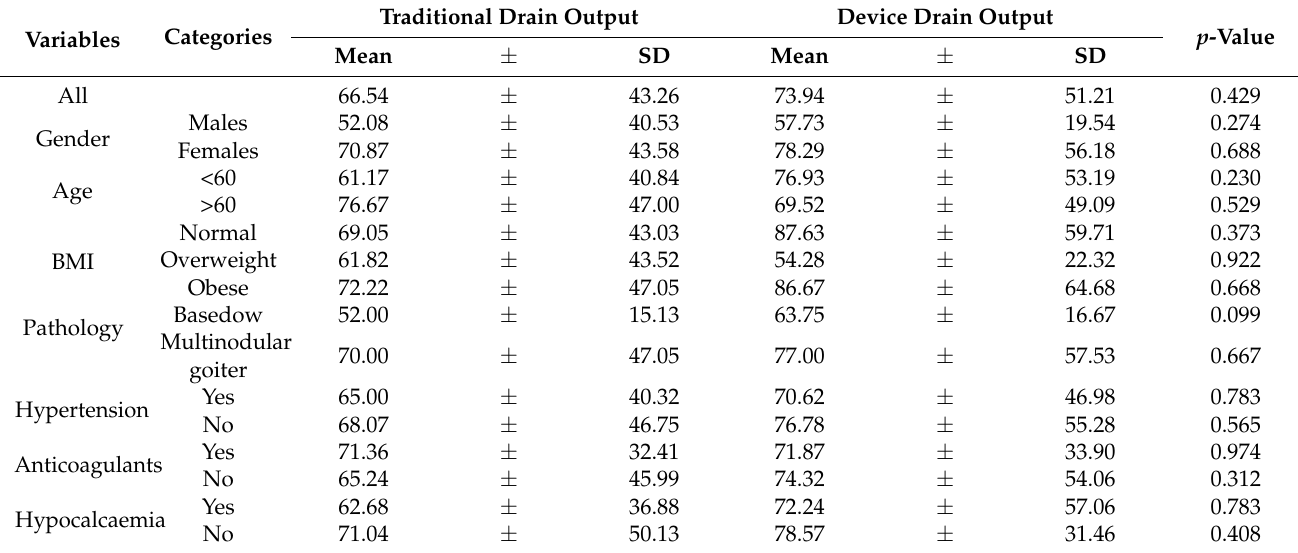
Table 9. Comparison between “Traditional” and “device” groups according to Drain output. Abbre- viation: BMI: Body Mass